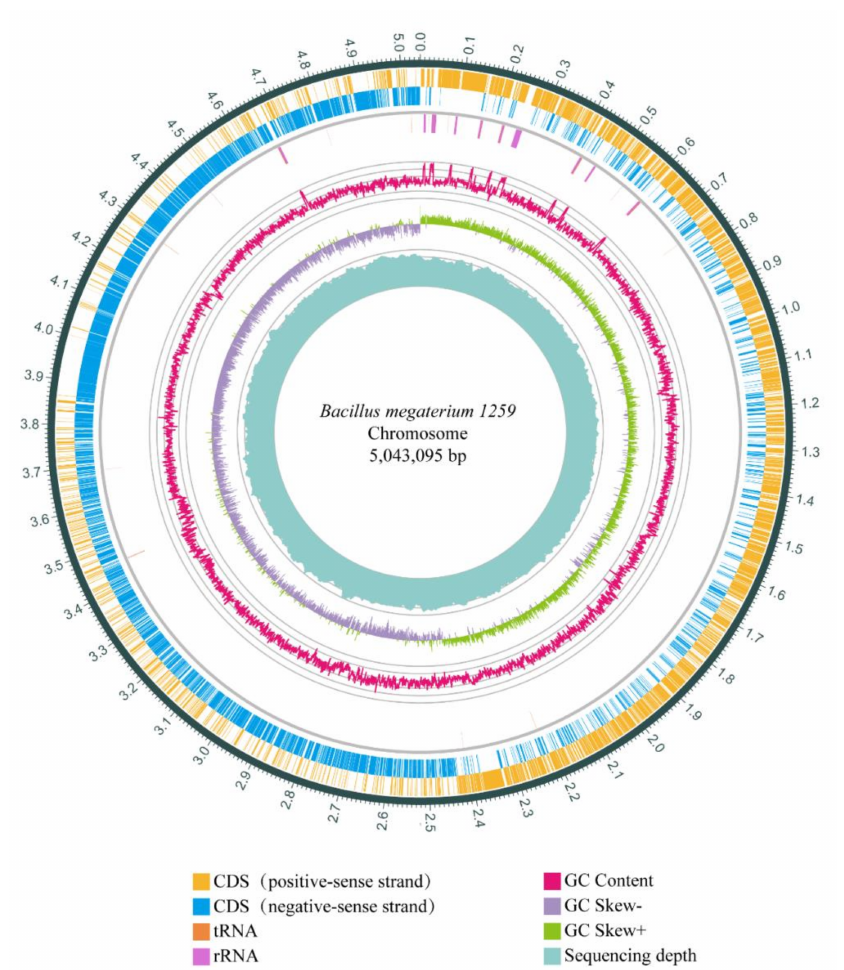
Figure 2. Circular chromosome of BM1259 genome. The first two outer circles indicate positive-sense and negative-sense strands with putative genes. The third circle represents tRNA and rRNA, depicted by orange and purple. The fourth and fifth circles indicate the GC content and the GC skew. The innermost circle represents the sequencing